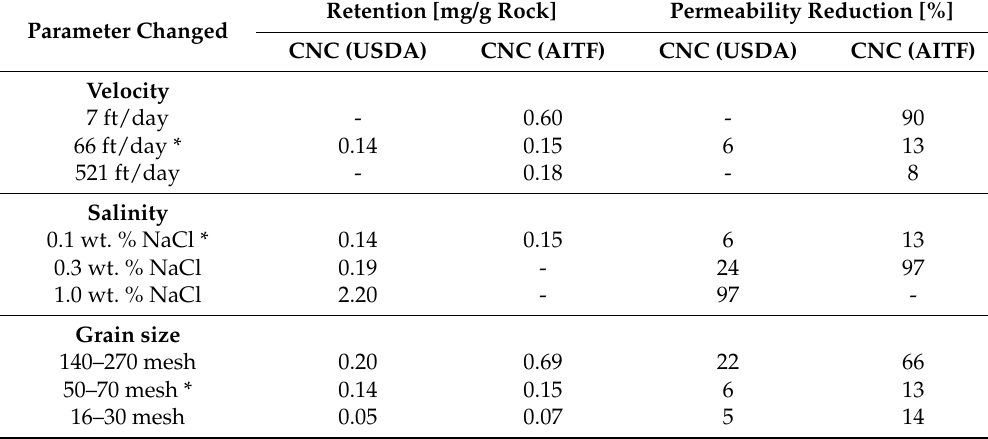
Table 5. Retained nanocellulose and permeability data from the sandpack flooding experiments. *, this is the base case experiment. For each parameter varied, the base case value was compared to two other